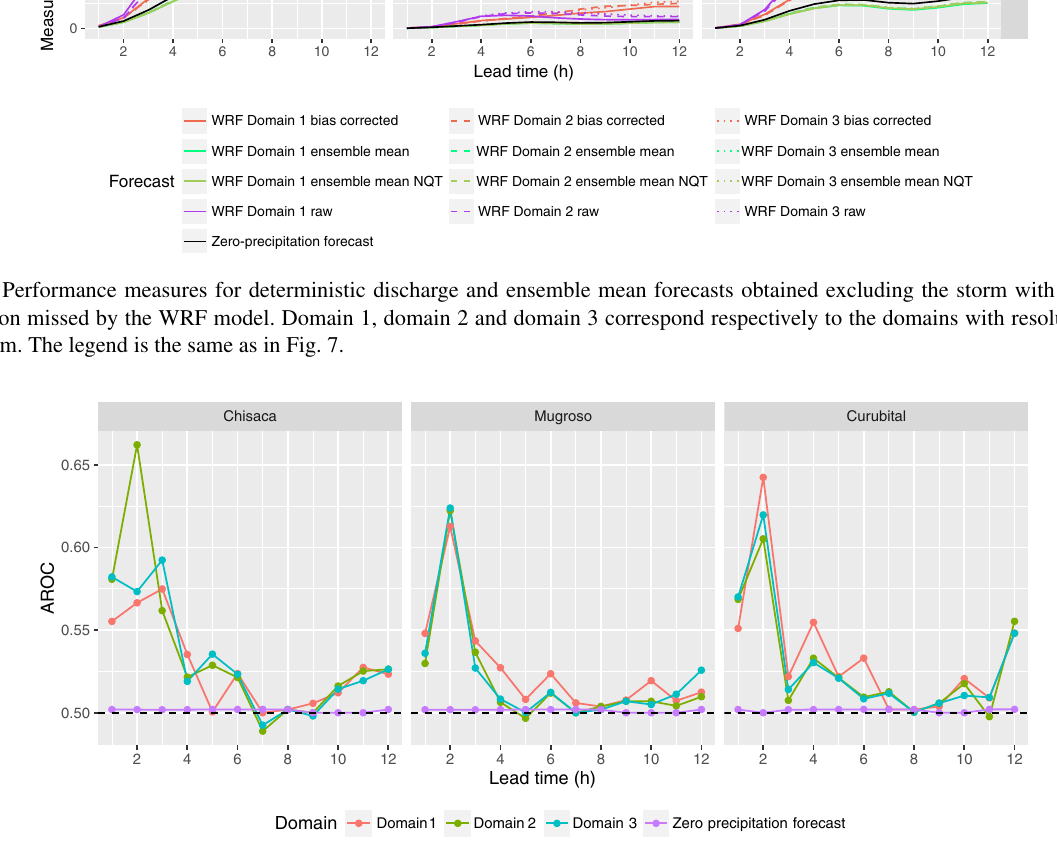
Figure 9. Area under the ROC curve (AROC) for the forecast of occurrence of precipitation with the probit model. Domain 1, domain 2 and domain 3 correspond respectively to the domains with resolutions 15, 5 and